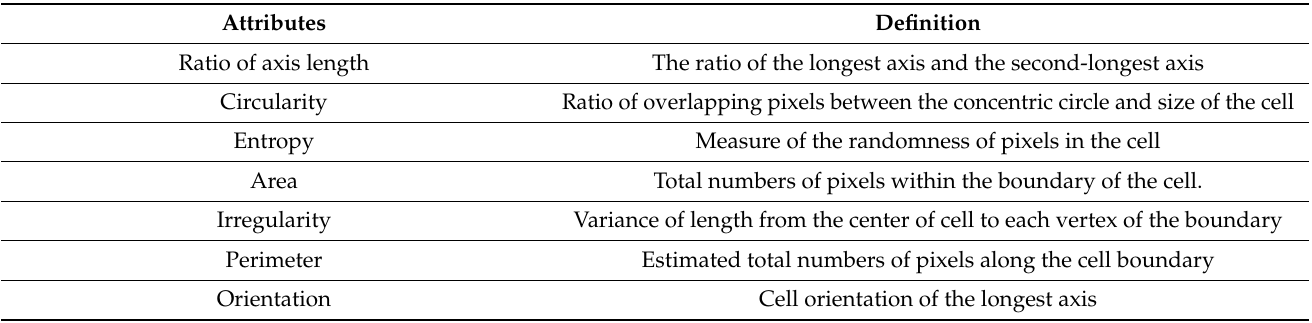
Table 3. Definition of attributes in cellular